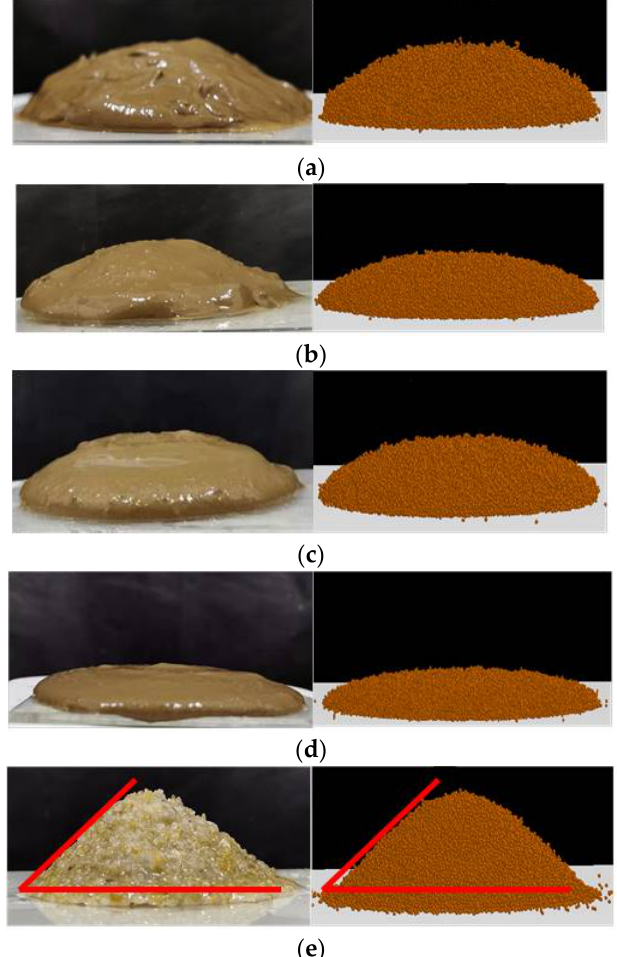
Figure 3. Soil accumulation test and DEM simulation. ( a ) Accumulation of clay. ( b ) Accumulation of mixed soil 1#. ( c ) Accumulation of mixed soil 2#. ( d ) Accumulation of mixed soil 3#. ( e ) Accumulation of sand.